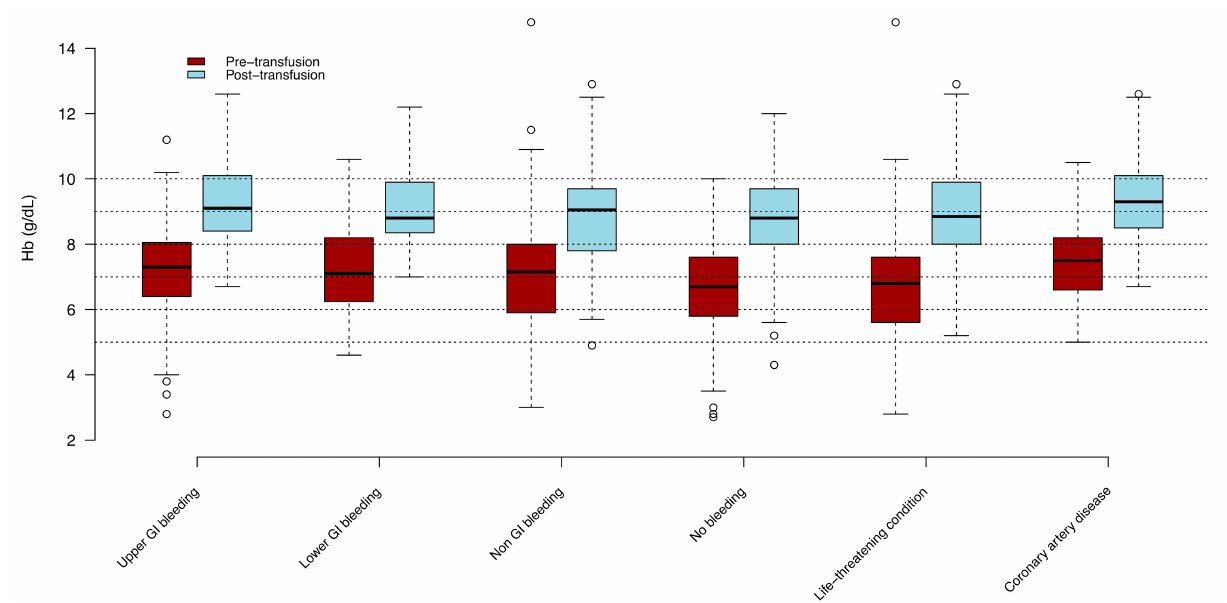
Figure 6. Boxplots of the pre-transfusion and post-transfusion Hb level in patients depending on the presence or absence of acute bleeding in the ED, a life-threatening condition (shock, dyspnea, altered mental status), and a history of coronary artery